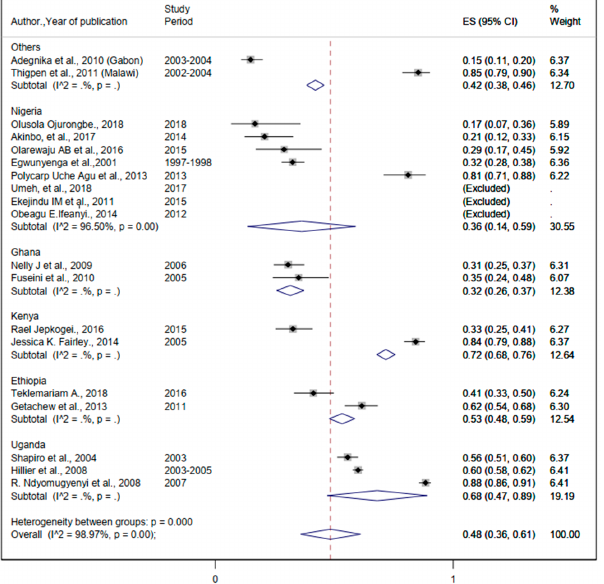
Figure 5. The proportion of Hookworm estimated from the overall helminthic infection among pregnant women in sub-Saharan Africa.